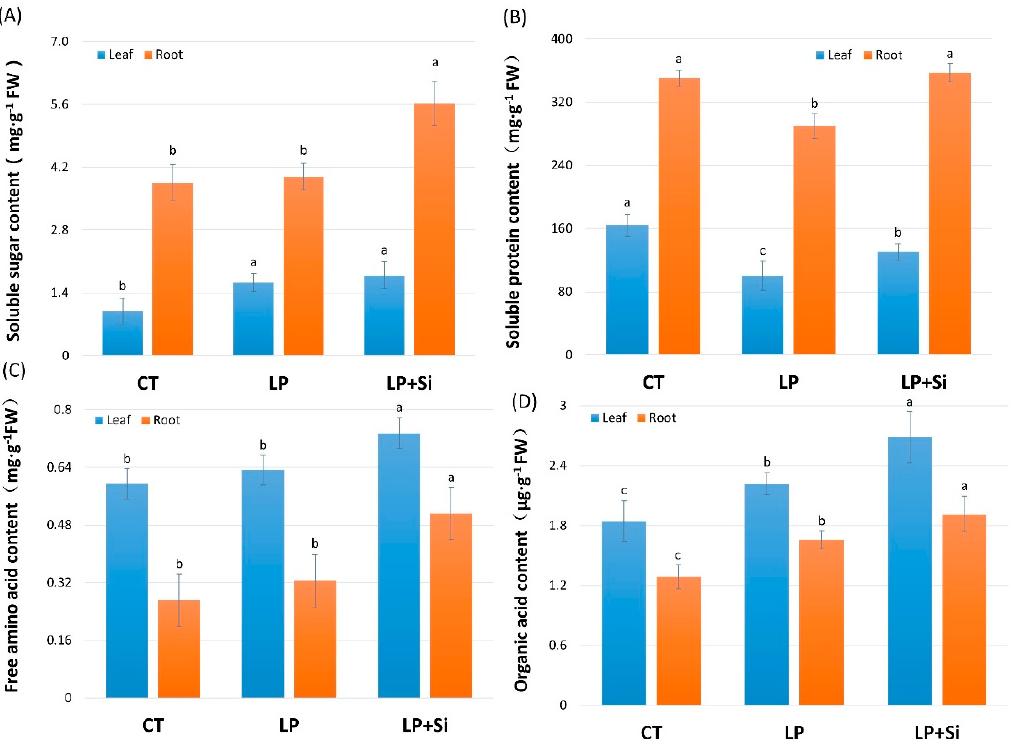
Figure 4. Changes in osmoregulatory substances as influenced by low phosphorus (LP) and exogenous silicon (Si) supply in tomato plants: ( A ) Soluble sugar content, ( B ) soluble protein content, ( C ) free amino acid content, and ( D ) organic acid content in tomato leaves and roots. Data are shown as means ± standard deviation (SD) of three replicates. Bars with the same color but different letters indicate statistically significant differences at p ≤ 0.05.